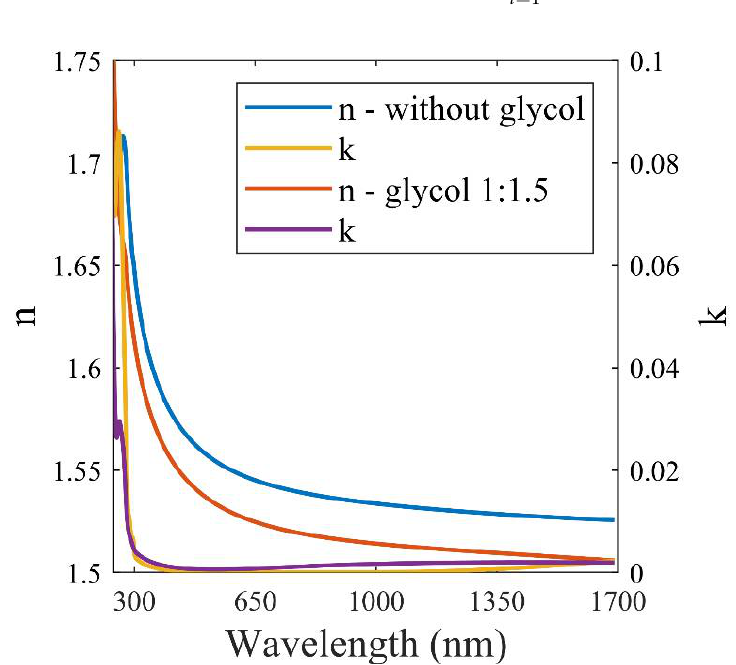
Figure 9. Refractive index (n) and extinction coefficient (k) vs. wavelength of polymerized [(N 11 VB) 2 Pr][Cl] on silicon substrate.